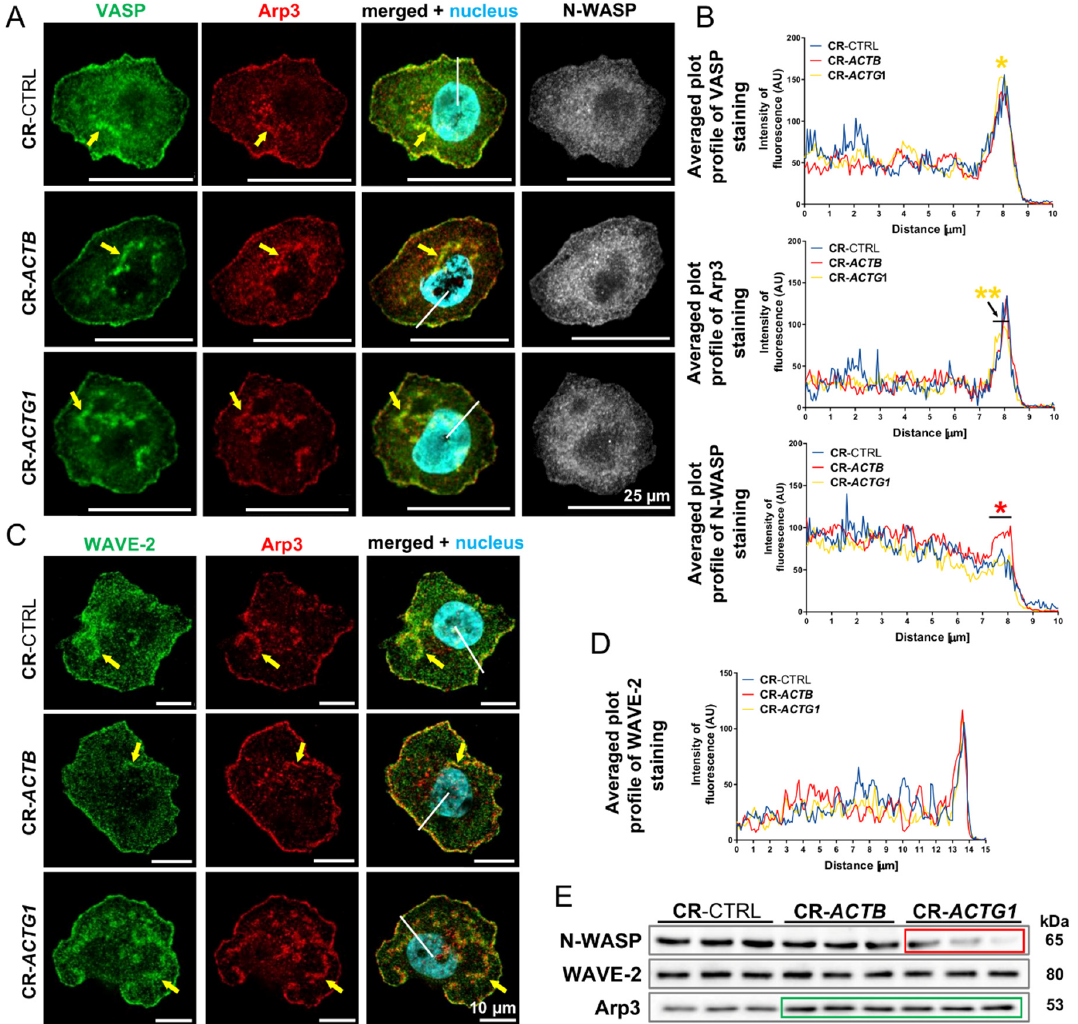
Figure 6. Changed distribution of actin binding proteins (ABPs) within leading edge upon lamellipodium formation challenge. ( A ) The cells were stained with vasodilator-stimulated phosphoprotein (VASP), actin-related protein 3 (Arp3), and neural Wiskott-Aldrich syndrome protein (N-WASP), recognizing antibodies. Yellow arrows point at circular dorsal ru ffl es. ( B ) Plots of averaged fluorescence intensity distribution of stained VASP, Arp3, and N-WASP. Lines were drawn from pericentral region of a cell (position 0 µ m) towards the border of a cell (10 µ m) ( n = 9). Representative white lines are shown on merged microphotographs in ( A ). Black arrow points at the range for which there is a statistically significant di ff erence for CR- ACTG1 cells in comparison to control cells. ( C ) The cells were stained using specific antibodies to detect Wiskott-Aldrich syndrome protein family member 2 (WAVE-2) and Arp3. Yellow arrows point at circular dorsal ru ffl es. ( D ) Plots of averaged fluorescence intensity distribution for WAVE-2 from the center of a cell (position 0 µ m) towards the border of a cell (position 15 µ m). Representative white lines are shown on merged microphotographs in ( C ). ( E ) Cell lysates were analyzed by Western blotting. Membranes were incubated with antibodies directed against N-WASP, WAVE-2, and Arp3. Corresponding densitometric analysis and Ponceau S stainings of membranes are shown in Figure S11. Forty µ g of protein was loaded on every lane. Green and red rectangles represent statistically higher and lower levels of protein, respectively, in comparison to control cells. Results are expressed as the mean only, p ≤ 0.05 (*), p ≤ 0.01